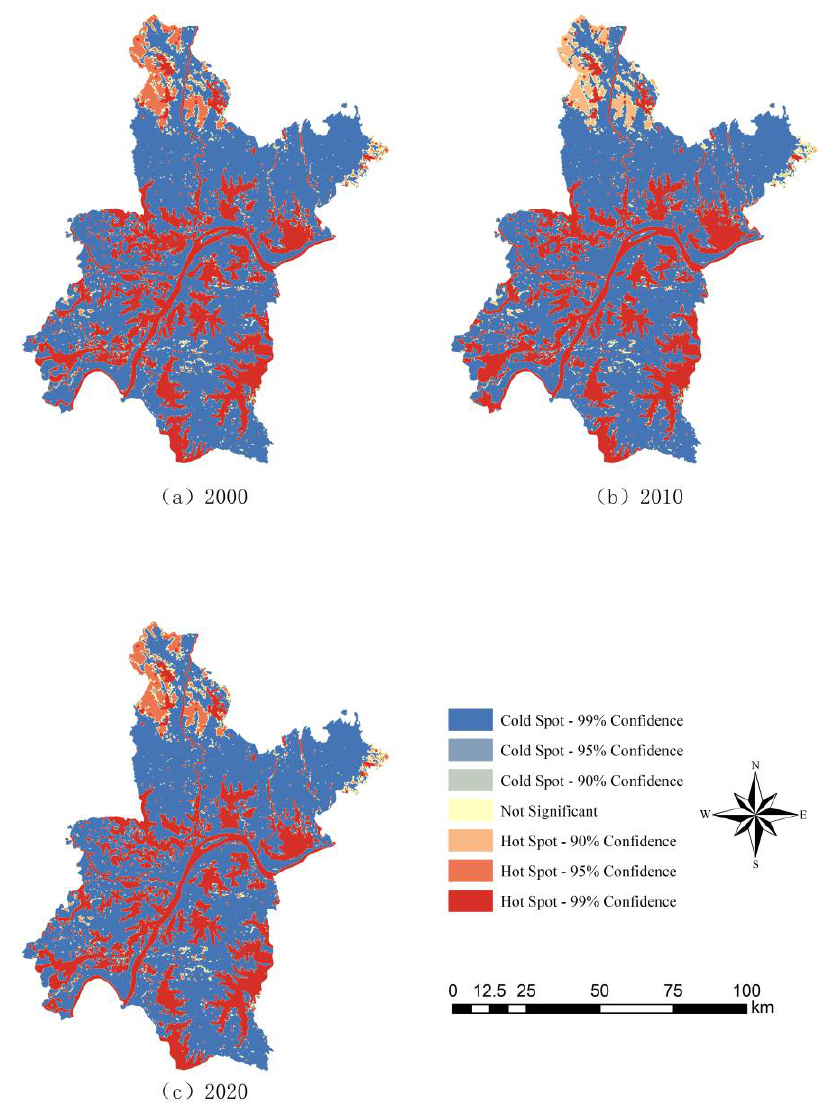
Figure 4. Hot spot analysis of ESVs in Wuhan during 2000 – 2020.